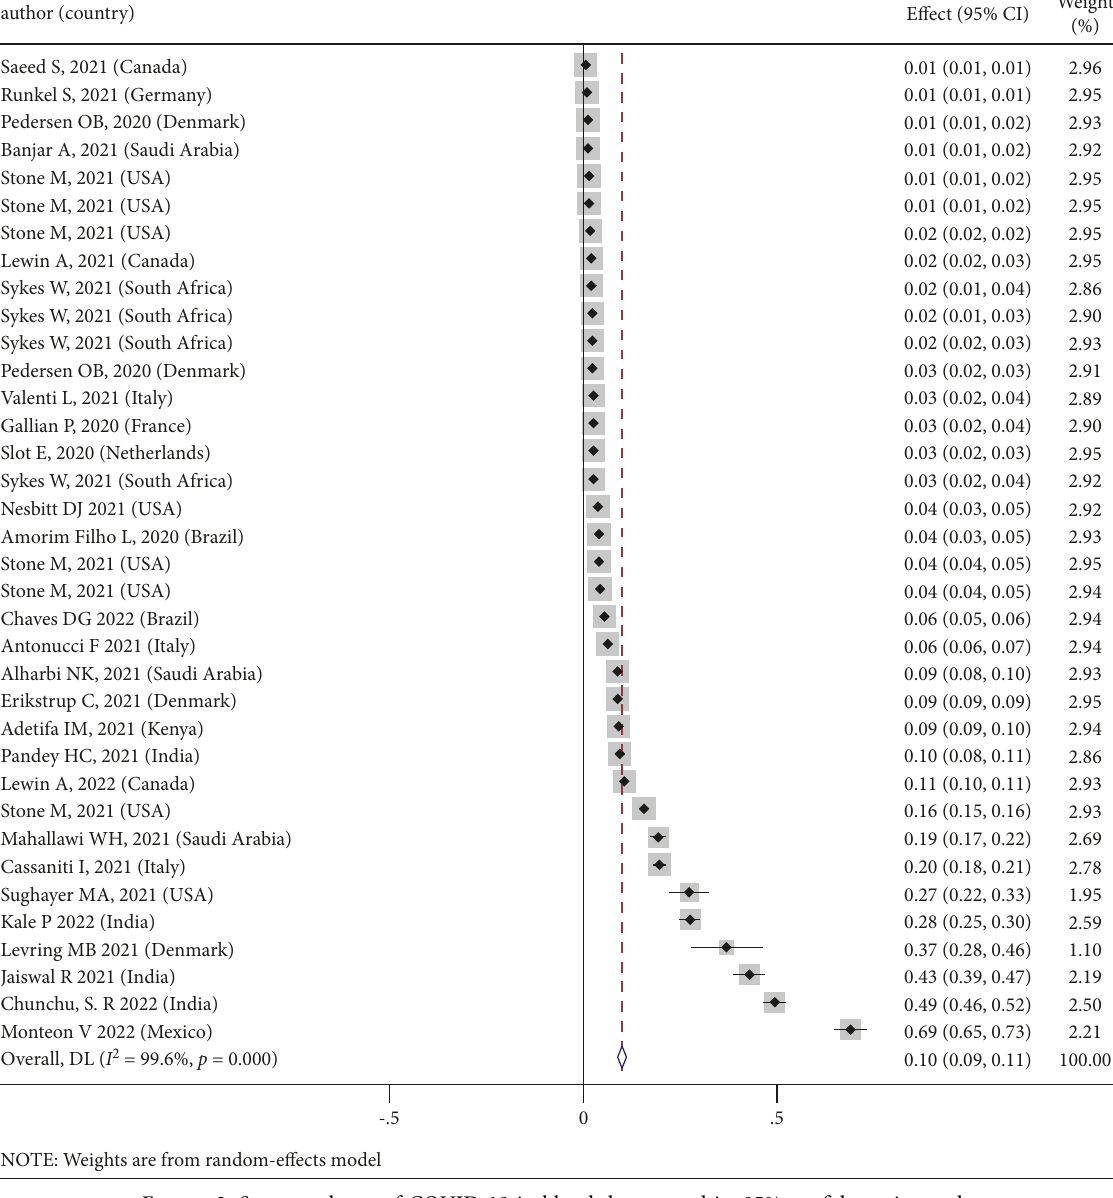
Figure 2: Seroprevalence of COVID-19 in blood donors and its 95% confidence